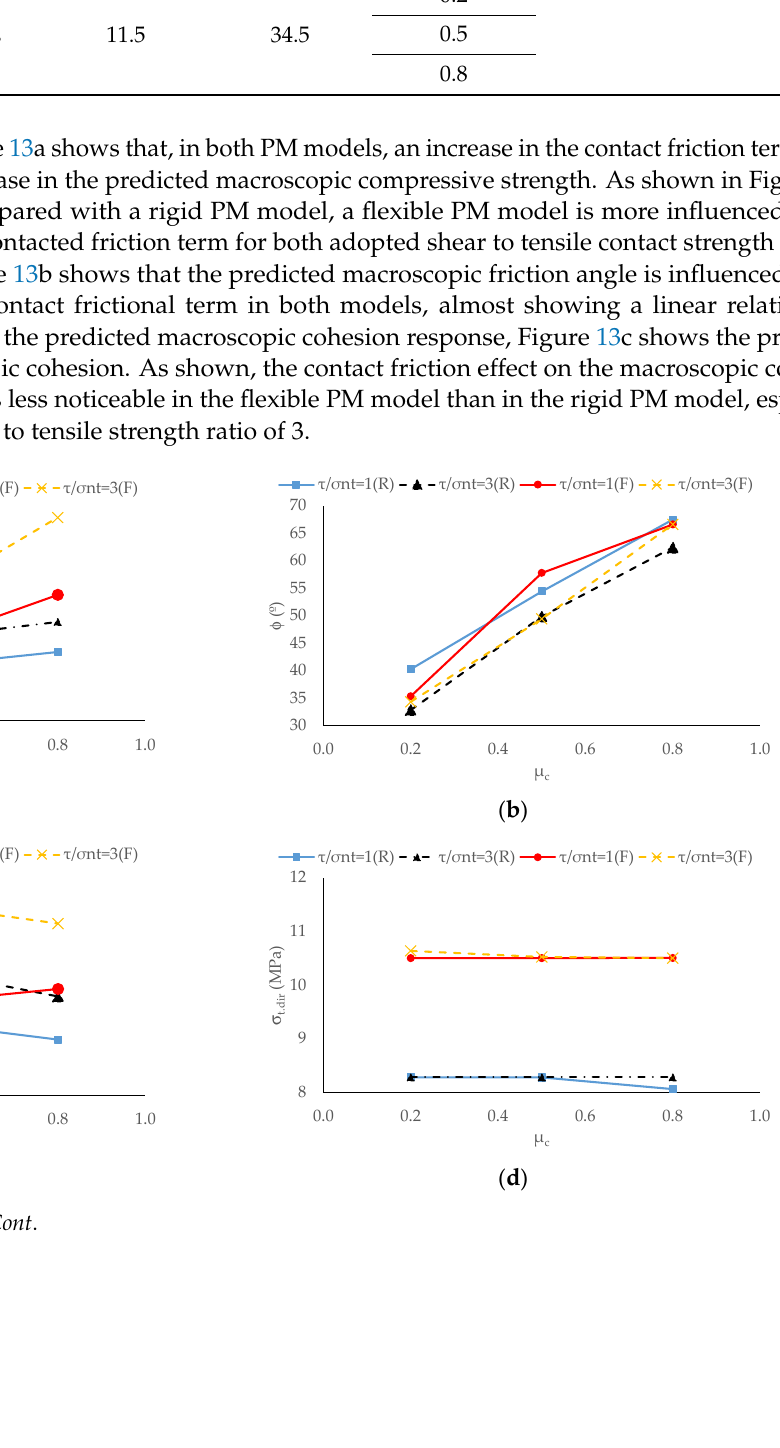
Table 6. Strength properties for the particle models: Influence of contact friction. Case